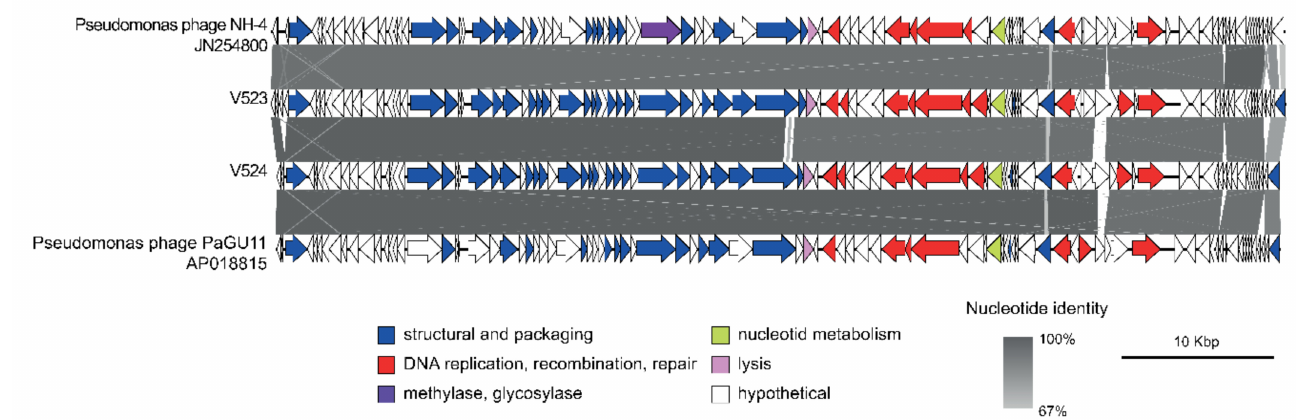
Figure 3. A synteny plot displaying the genome structure of phages V523 and V524, as well as their identity to other closely related Pbunavirus phages. The figure was created using Easyfig [42] and the genomes are displayed linearly for visualization. Detailed information regarding the gene annotation can be found in Supplementary Table